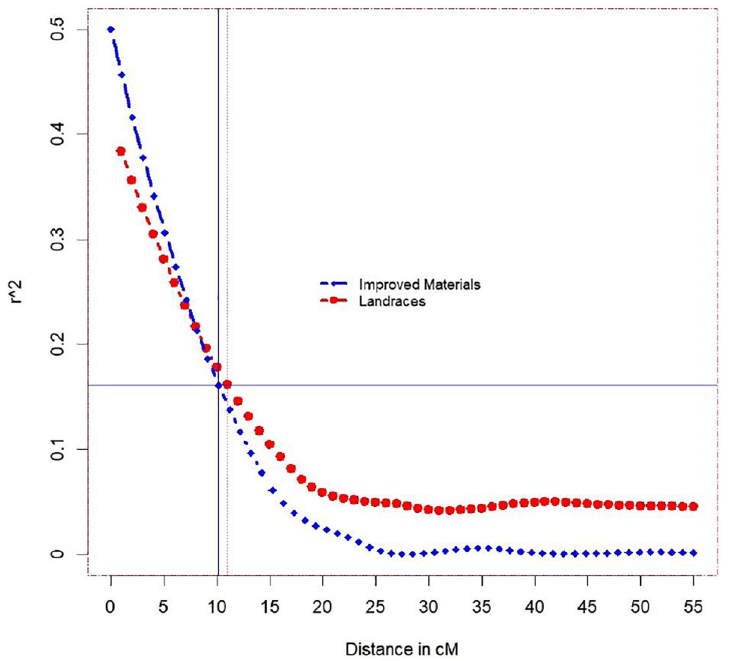
Fig 5. Genome-wide linkage disequilibrium (LD) decays for the landraces and the improved accessions using 3215 SNP markers.